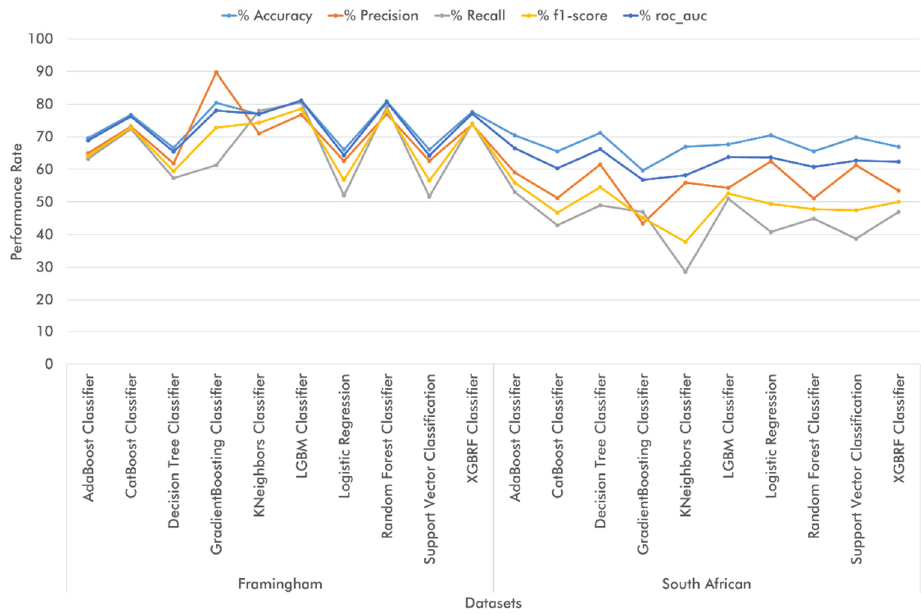
Figure 5. Train-test set performance of ten ML classifiers on the top-four attributes from the Framingham and South African Hearth